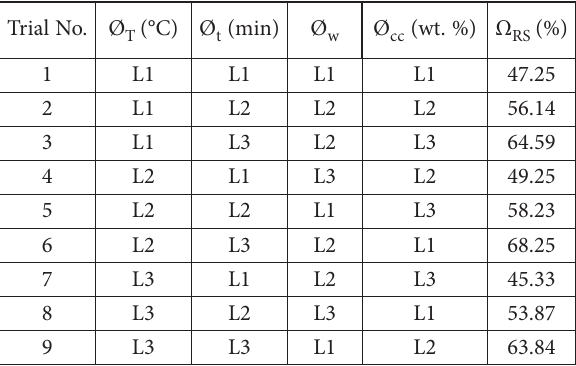
Table 2. Taguchi orthogonal design layout for photocatalytic